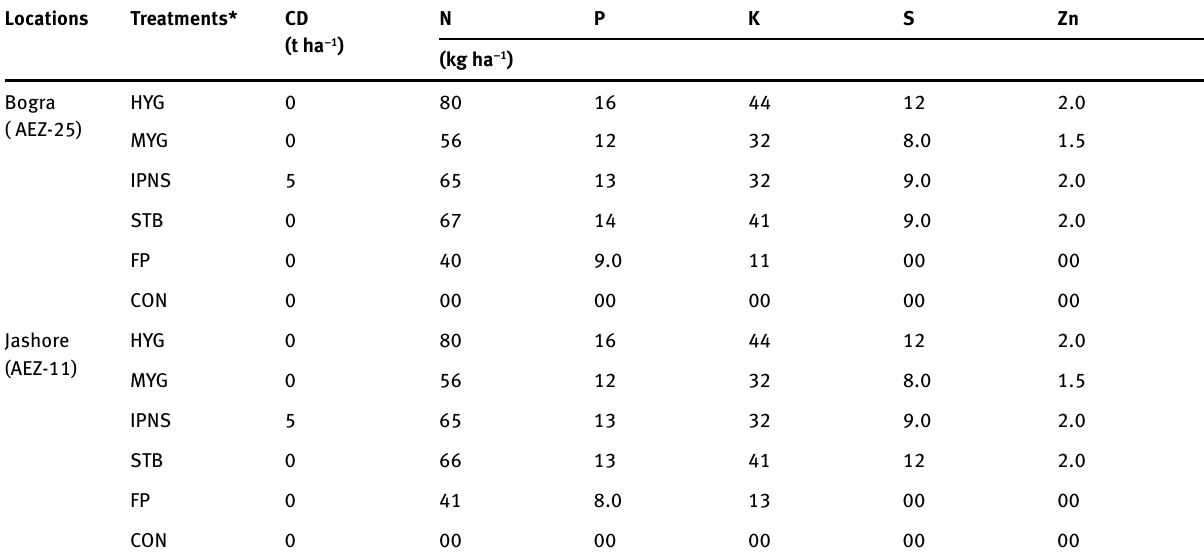
Table 2: Treatment details for 12 treatments (6 without and 6 with CRI) for two locations of Bangladesh Locations